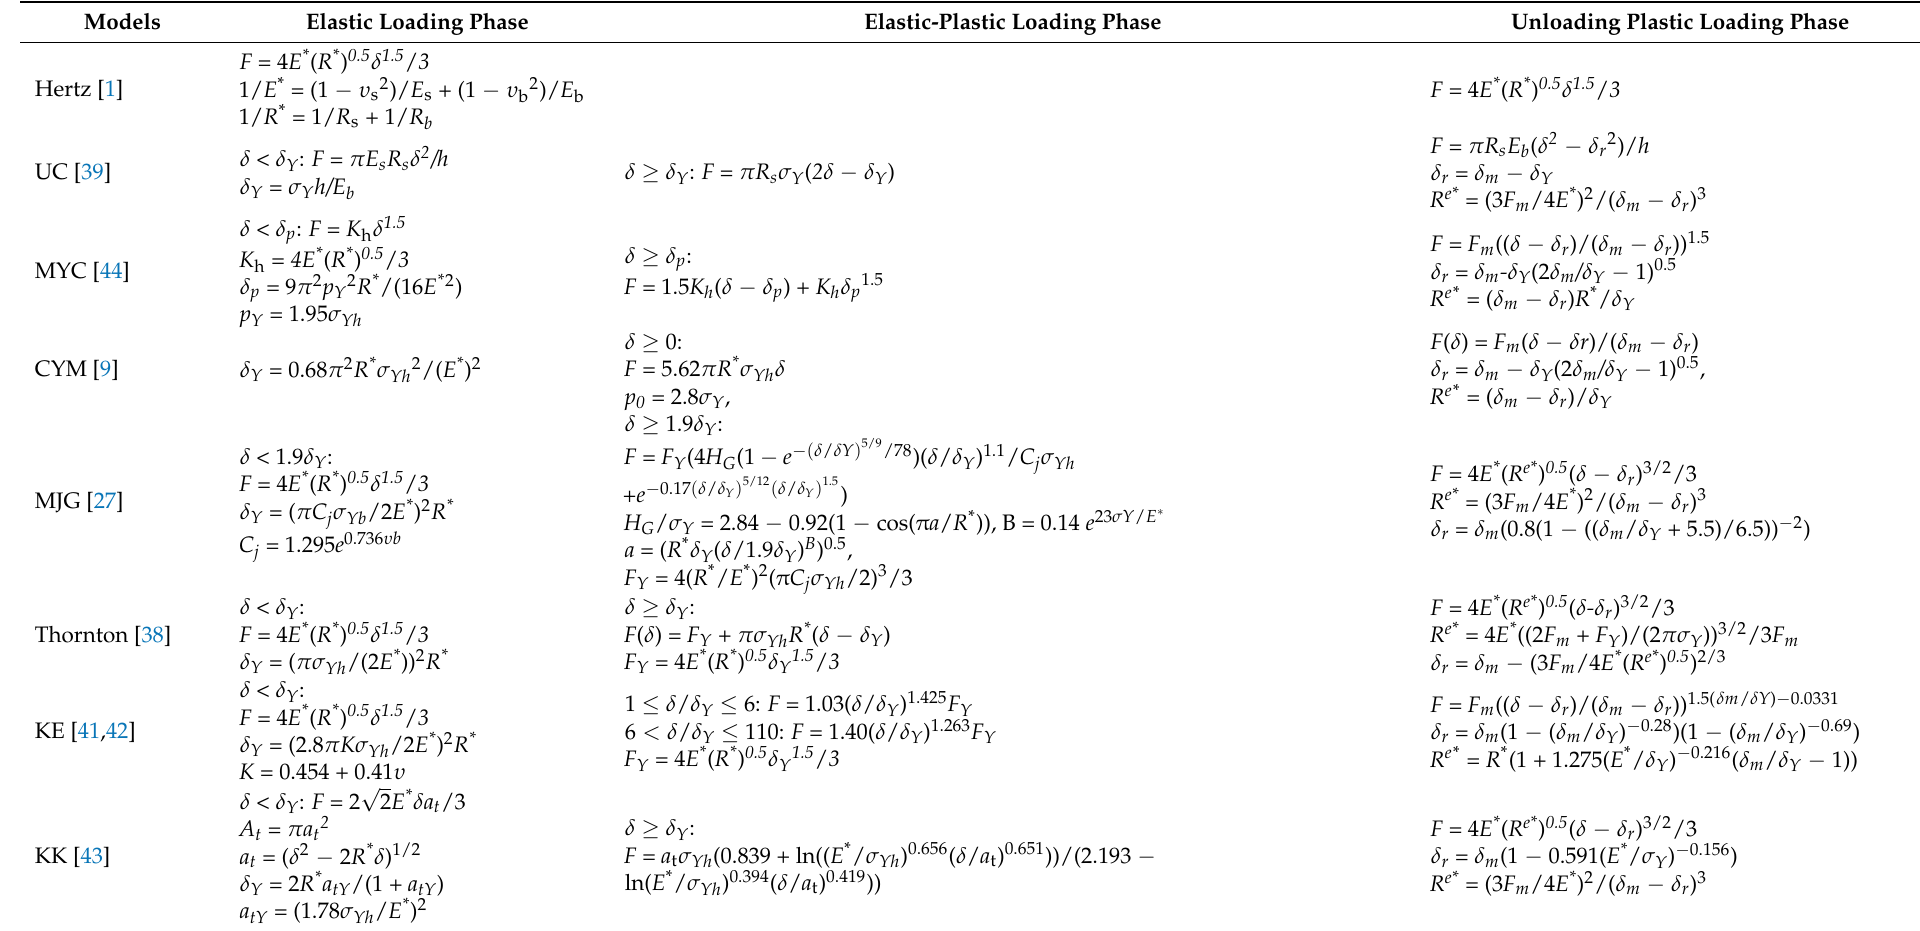
Table 1. The formulae of ten local contact